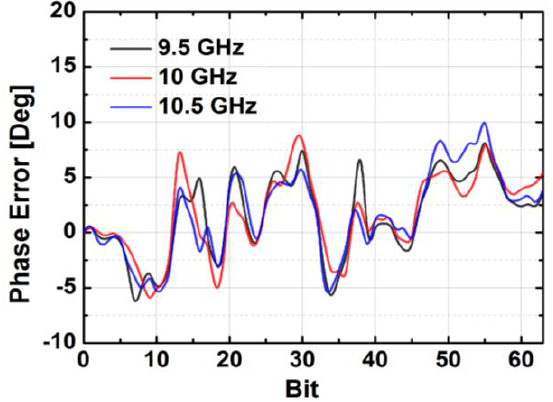
Figure 30. The phase errors of all phase shifting states at different frequencies.